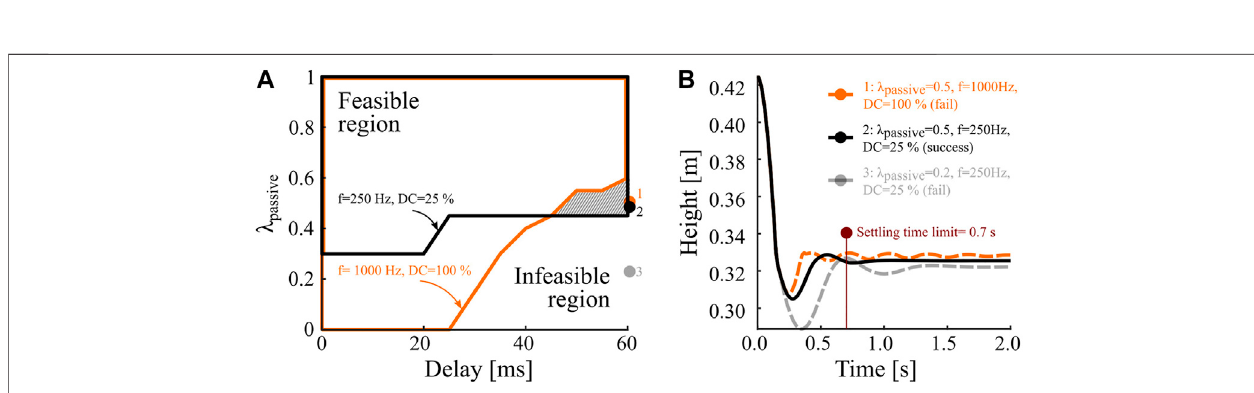
Frontiers in Robotics and AI |